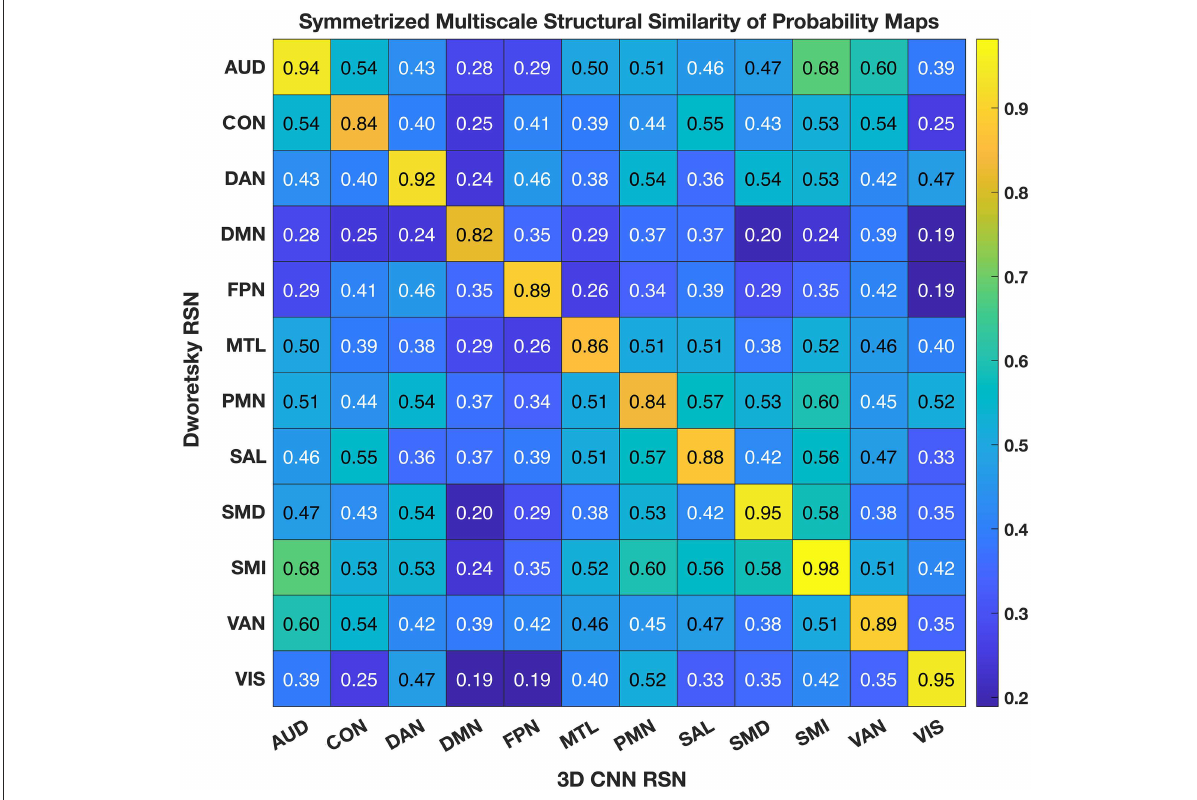
difference relates to the hierarchical structure of RSNs (60,